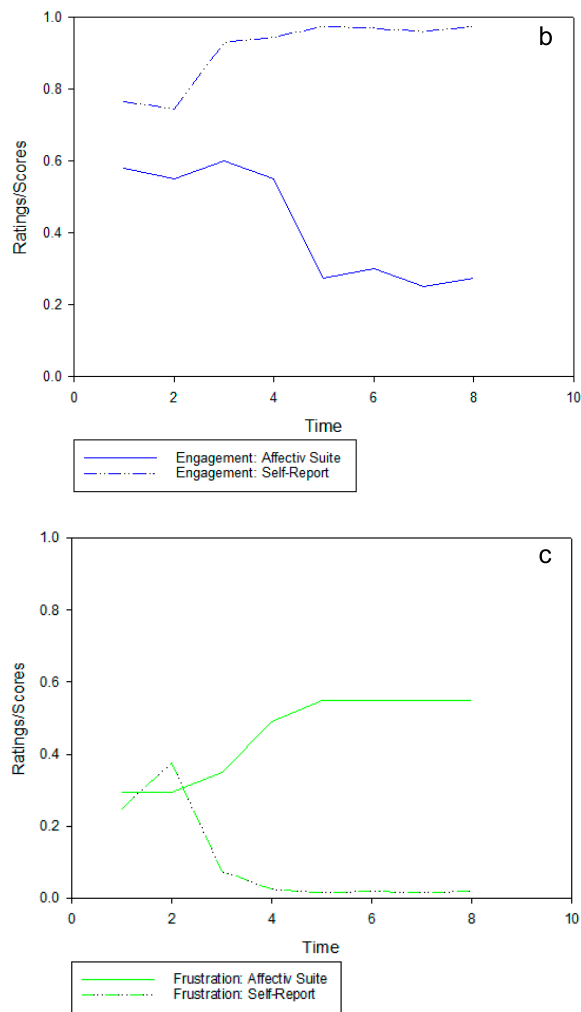
Figure 4. Affectiv suite and self-report outputs (( a ) “excitement”, ( b ) “engagement”, and ( c ) “frustration”) during the urban busy to urban green walking route. Time points 1–4 refer to the first section of the walk (urban busy) and time points 5–8 refer to the second section (urban